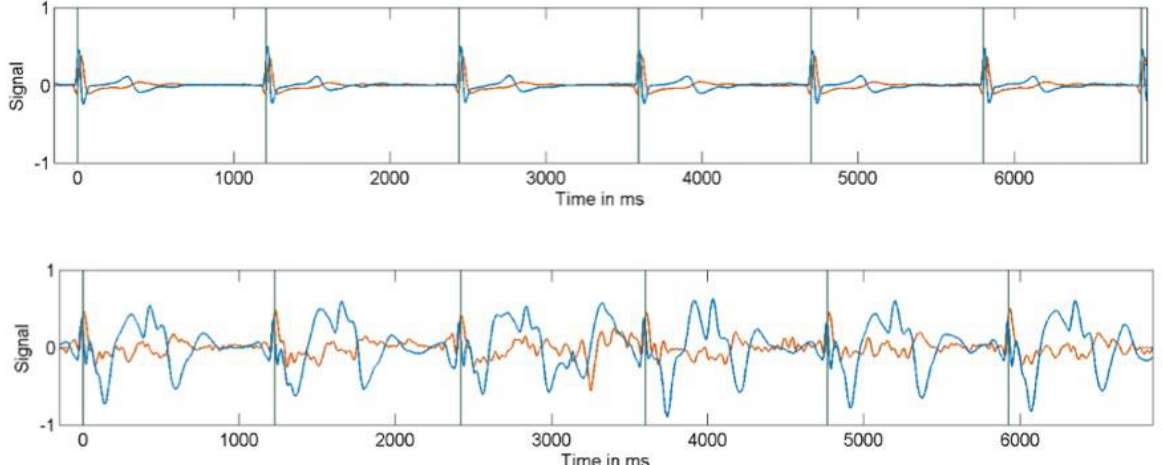
Figure 1. Electrocardiogram (ECG) signals obtained both outside (upper) and inside the magnet bore (lower figure), demonstrating the interference from the magnetic field.